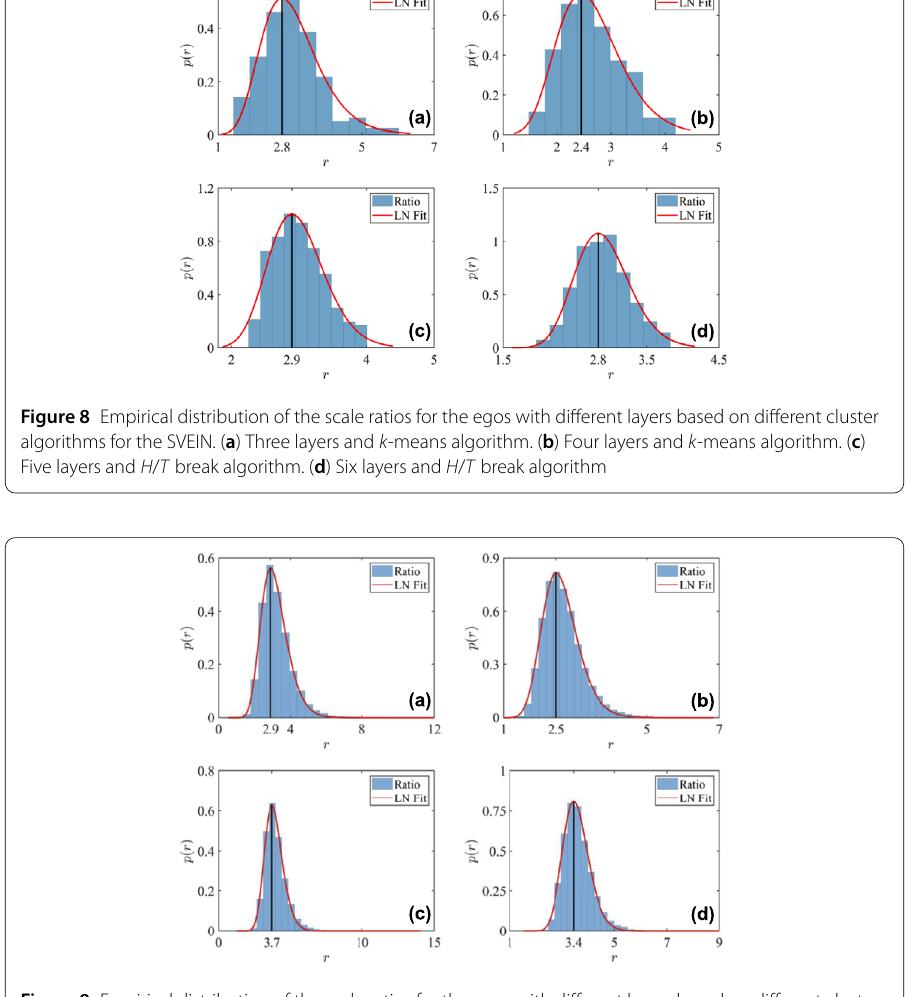
Figure 9 Empirical distribution of the scale ratios for the egos with different layers based on different cluster algorithms for the SVCN. ( a ) Four layers and k -means algorithm. ( b ) Five layers and k -means algorithm. ( c ) Four layers and H / T break algorithm. ( d ) Five layers and H / T break